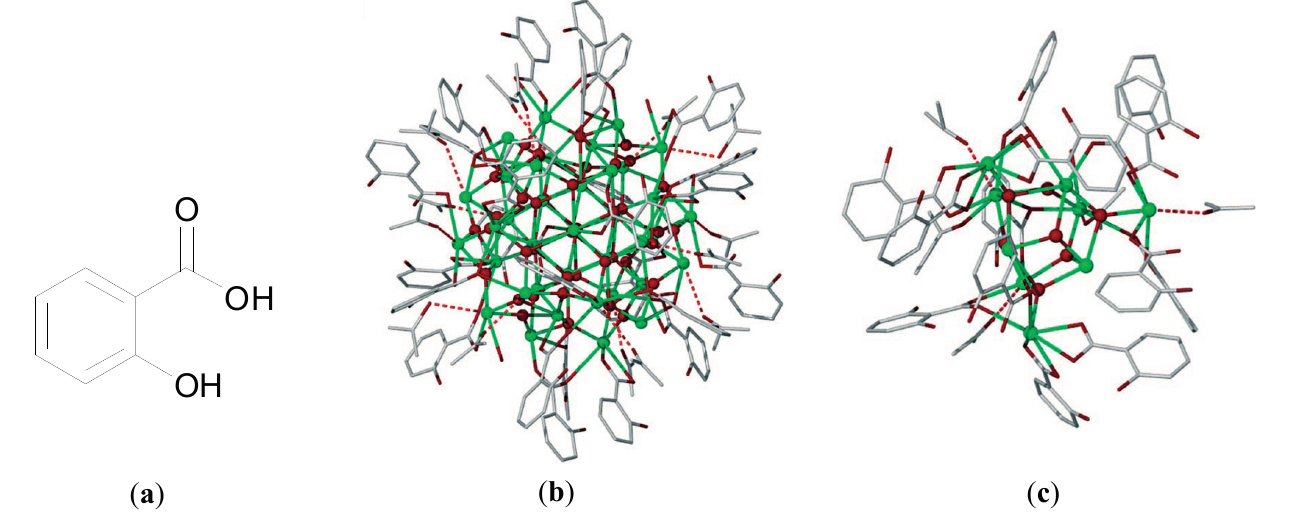
Figure 5. ( a ) Structure of salicylic acid; ( b ) Molecular structure of [Bi 38 O 44 (HSal) 26 (Me 2 CO) 16 (H 2 O) 2 ] showing the shrouding of the Bi 38 O 44 core (green = Bi, red = O) by 26 salicylate ligands (stick structures); ( c ) Molecular structure of [Bi 9 O 7 (HSal) 13 (Me 2 CO) 5 ] ( 2 ) showing the shrouding of the Bi 9 O 7 core (green = Bi, red = O) by 13 salicylate ligands (stick structures) [56]. Subfigures b and c are reproduced from [56] with permission from John Wiley and Sons,